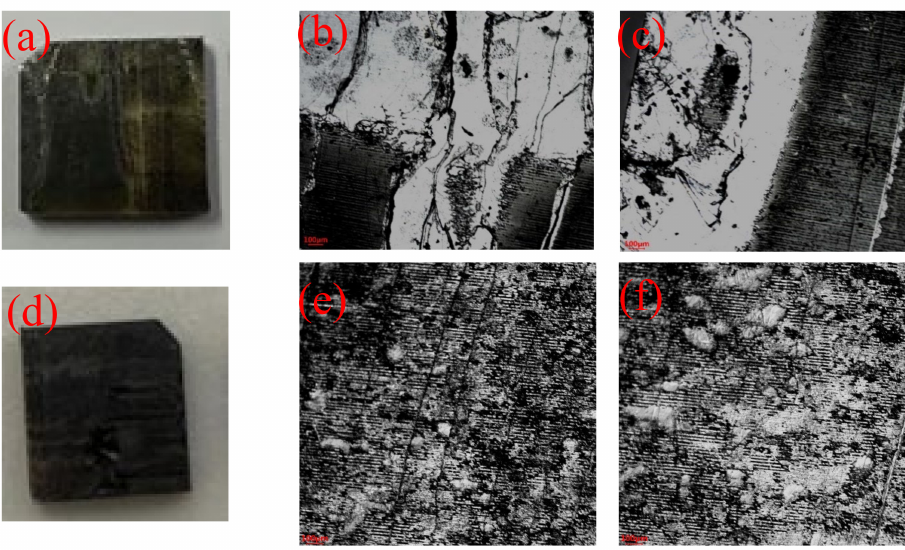
Figure 8. The microscopic observation of the stripping interface. ( a – c ) Sample-3 ( d – f )